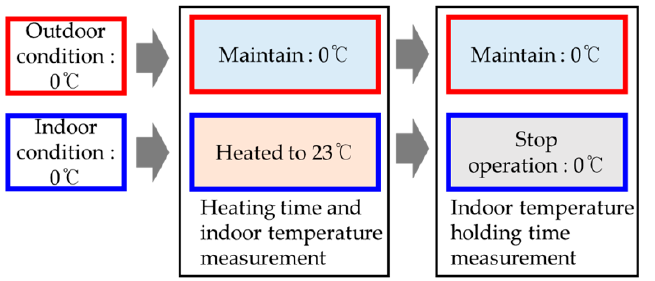
Figure 12. Evaluation procedure of headliner insulation performance.